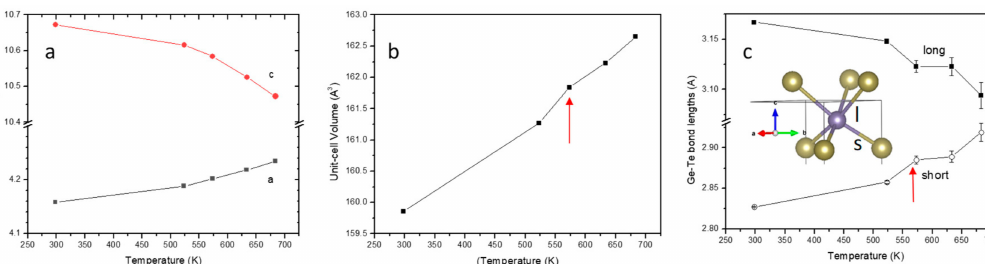
Figure 3. Views of the rhombohedral crystal structure, highlighting the evolution of the displacement parameters with temperature, from NPD data.